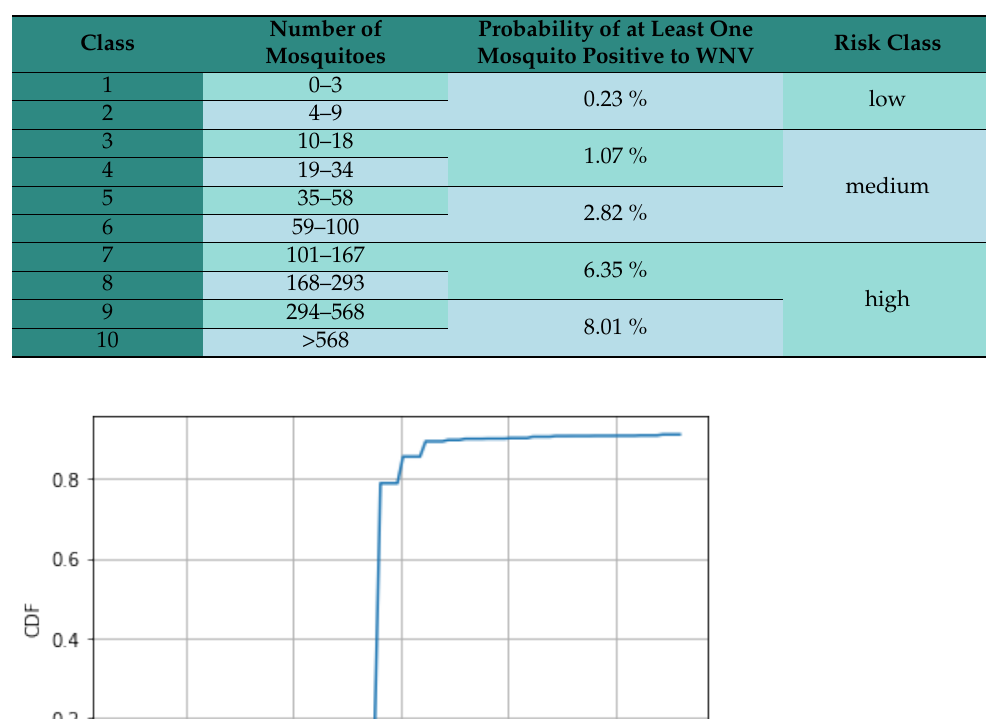
Table 1. Culex mosquito risk classes.